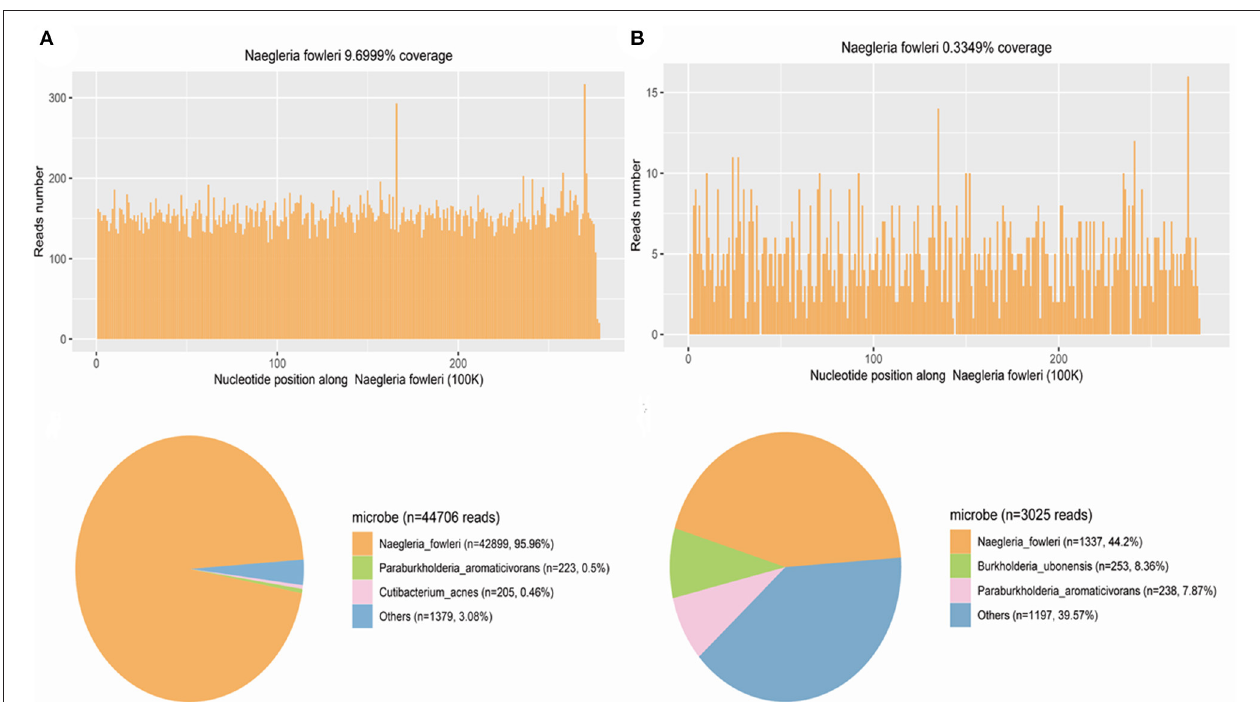
FIGURE 3 | NGS result. (A) N. fowleri infection diagnosis based on NGS on CSF sample. The upper panel is the N. fowleri reads in CSF on the genome mapping, whereas the distribution of the reads of microbes and unclassified reads without human host reads. The number of N. fowleri specific sequences is 42,899, which occupies 95.96% of all microbe sequences, with high confidence of N. fowleri infection. (B) NGS on serum sample for N. fowleri infection diagnosis. The N. fowleri reads in serum on the genome mapping are on the upper panel, whereas the reads distribution of microbes and unknown sequences in the absence of human host reads. There are 3,025 N. fowleri specific sequences that take up 44.2%of all microbe sequences, in high confidence of N. fowleri